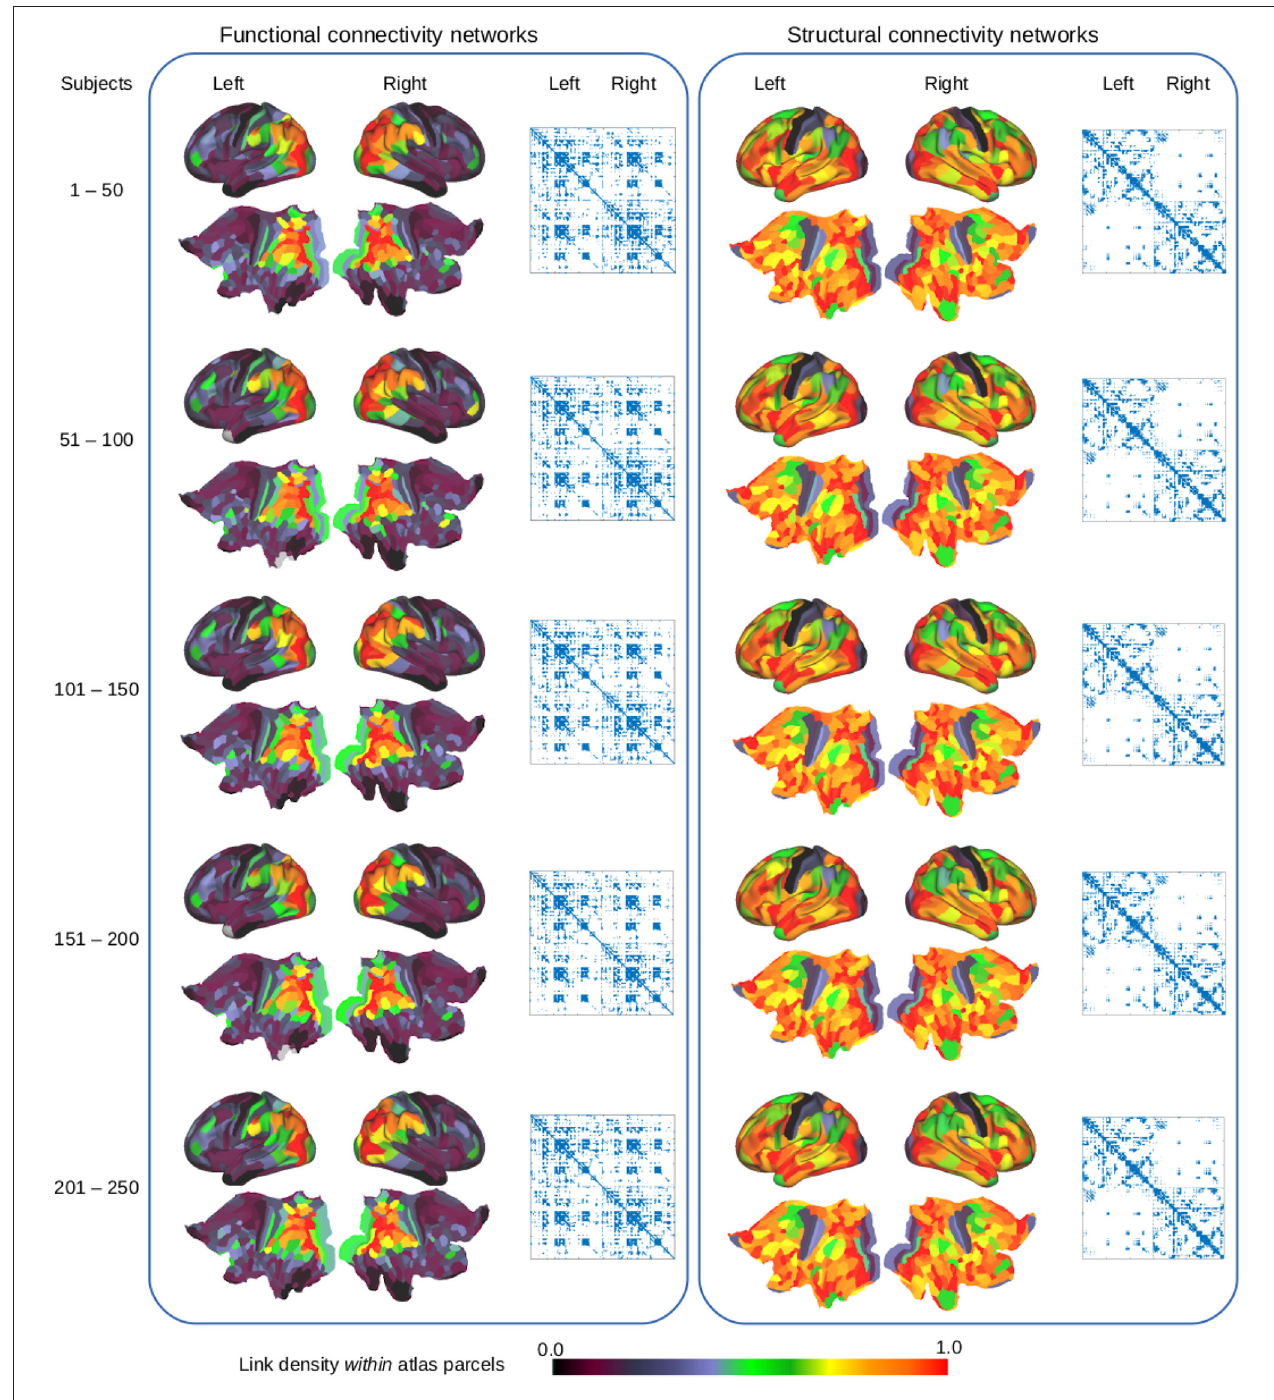
FIGURE 2 | Examination of functional connectivity (left) and structural connectivity (right) using the HCP_MMP1.0 atlas parcellation (Glasser et al., 2016). The cortical surface and flatmaps show the link-density within each of the 360 atlas parcels whereas the adjacency matrices outline the whole brain functional and structural connectivity graphs, based on the average of different populations of 50